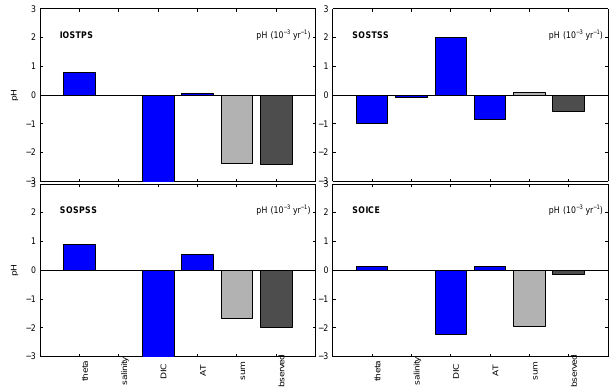
Figure 9. The long-term trends in pH from Fig. 4 decomposed into the contributions from SST, SSS, alkalinity, and DIC. Also shown is the sum of the four contributions and the actual observed trend. Note that the trend has been multiplied by 1000 for easier